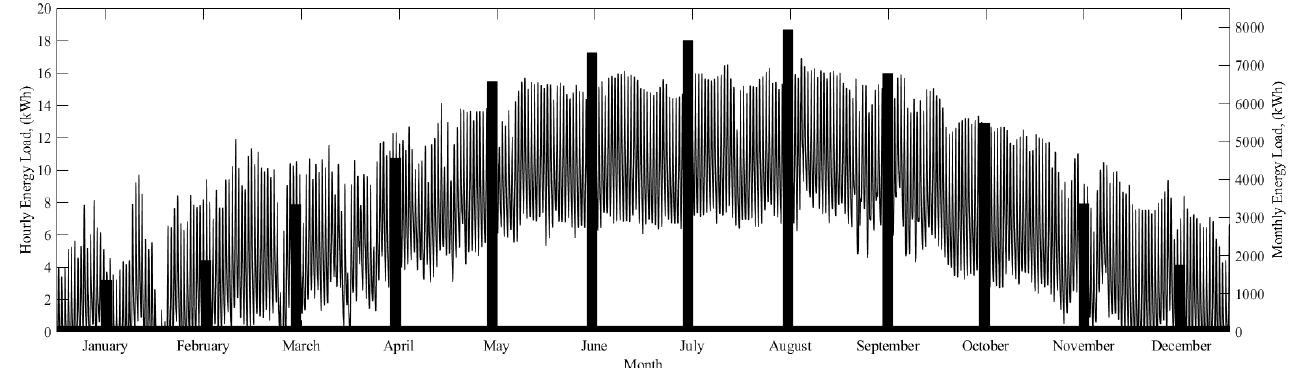
Figure 11. Hourly and monthly cooling load for a 197 m 2 villa in Riyadh,